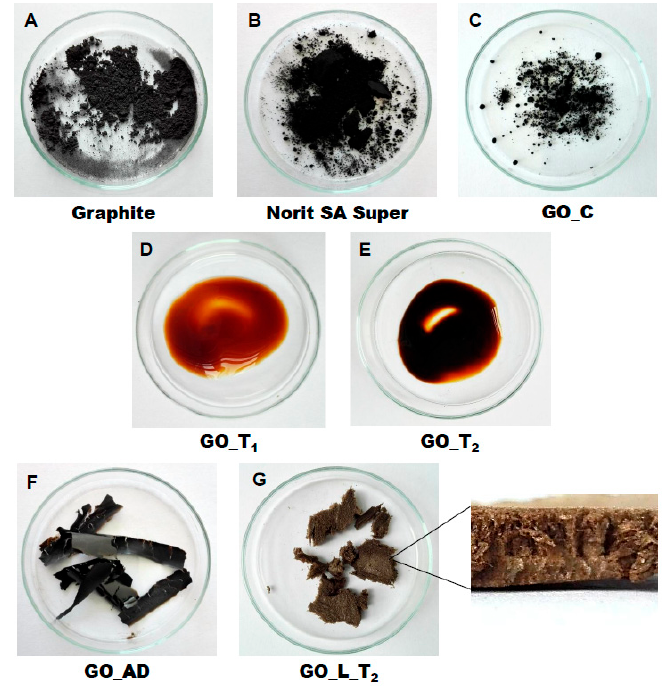
Figure 2. General view of investigated carbon materials: graphite ( A ), activated carbon Norit SA Super ( B ), commercial graphene oxide—GO_C ( C ), graphene oxide—GO_T 1 ( D ), graphene oxide—GO_T 2 ( E ), graphene oxide after air drying—GO_AD ( F ) and GO after lyophilization—GO_L ( G